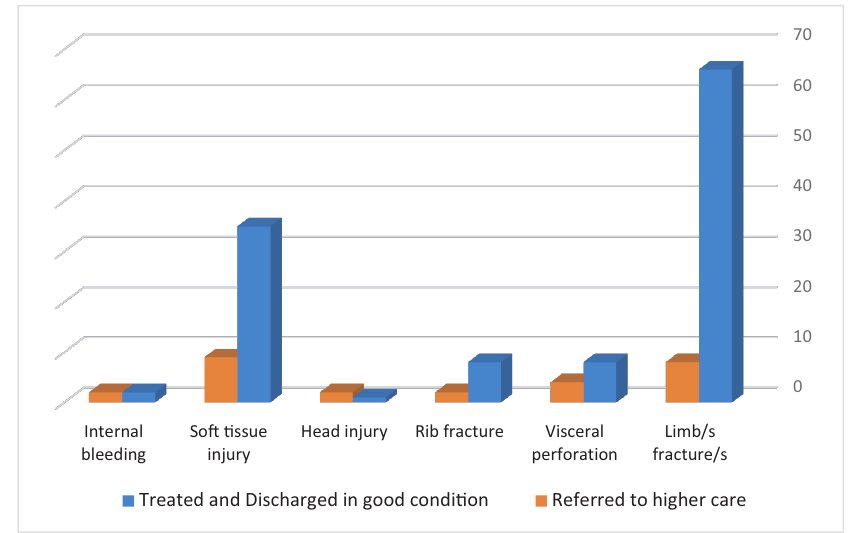
Figure 1 : Patients who were treated or referred based on their